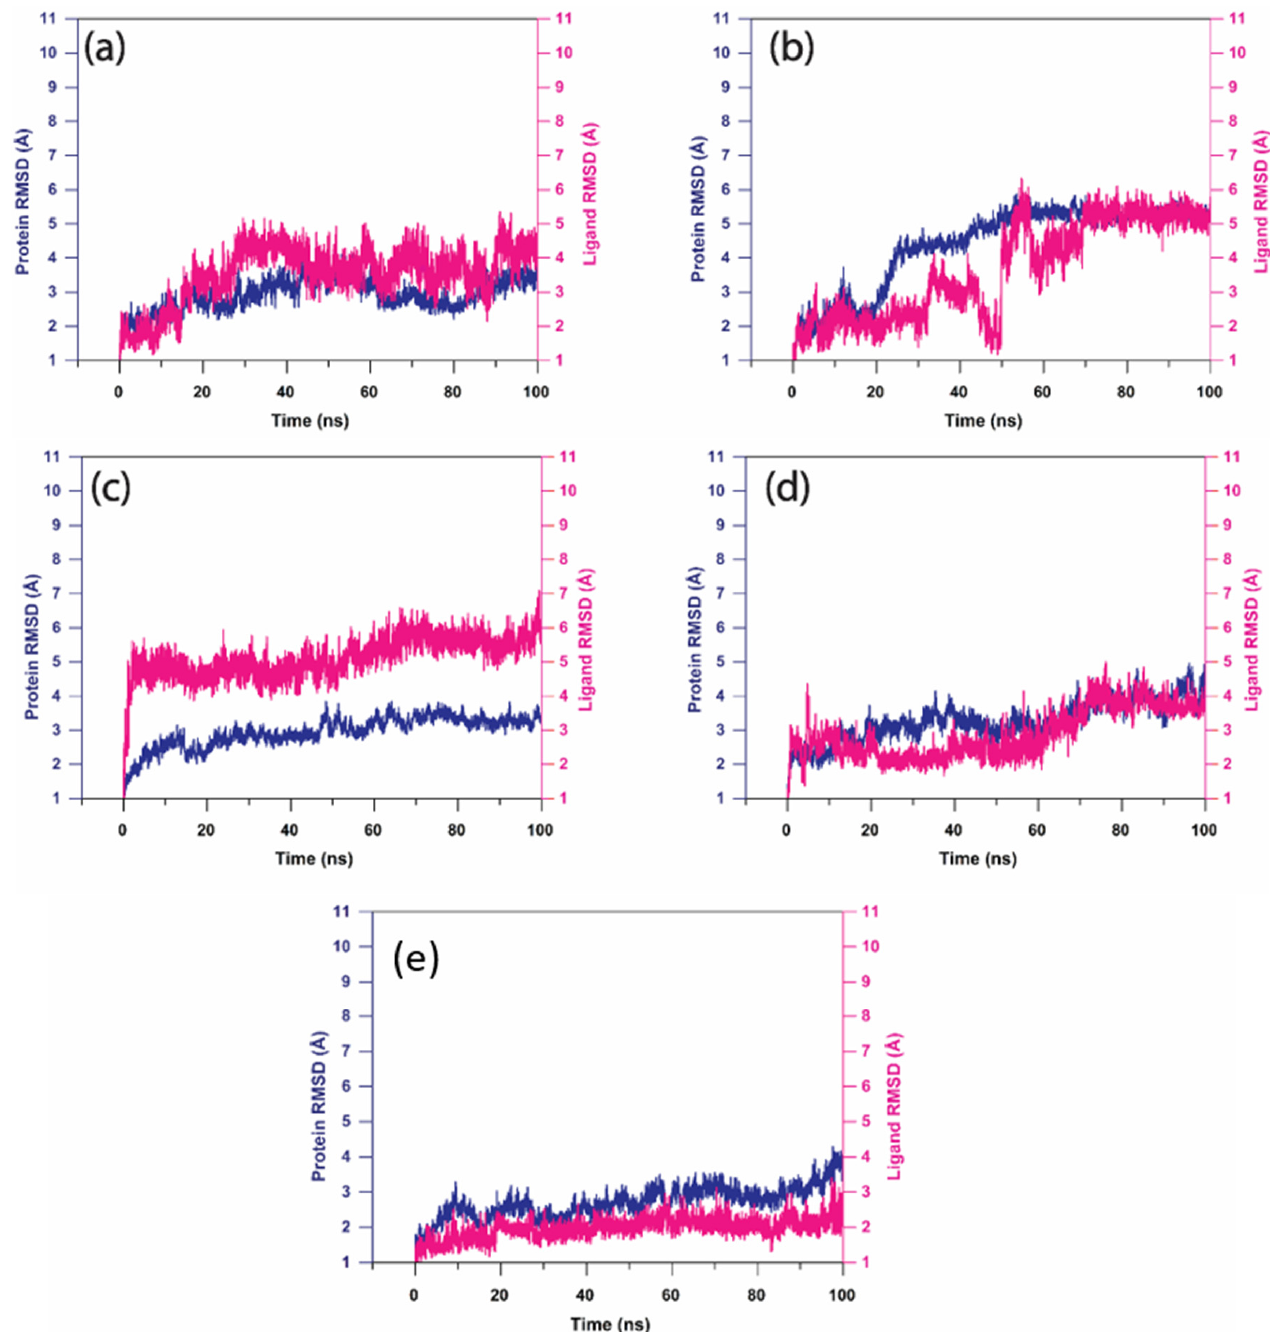
Figure 5. RMSD analysis on the docked viral proteins and ligands, i.e., natural compound trajectories ( a ) Gallicynoic Acid F, ( b ) H2 Erythro-Neopterin, ( c ) Nigcollin C, ( d ) NPA024545, and ( e ) Vaccinol M.